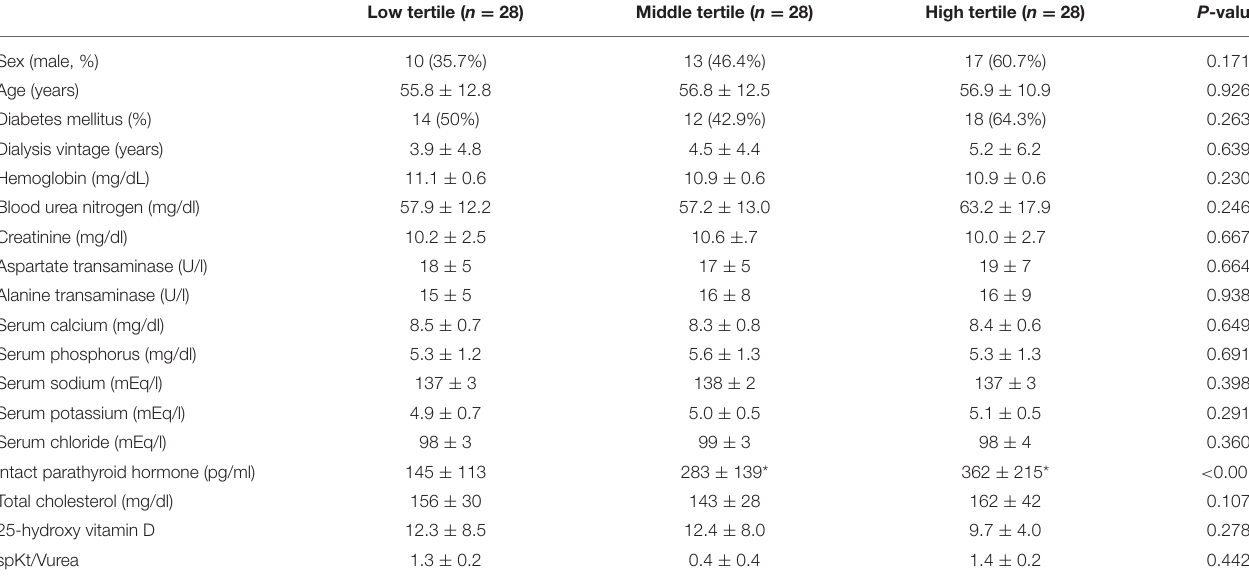
TABLE 1 | Demographic and laboratory findings according to tertiles of alkaline phosphatase. Participants’ clinical characteristics. Low tertile ( n = 28) Middle tertile ( n = 28) High tertile ( n = 28)